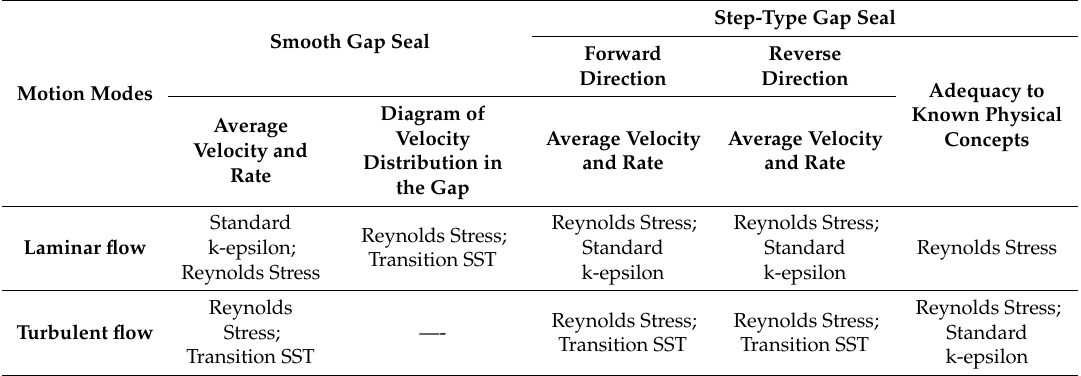
Table 9. The results of the analysis on using various flow models for calculating gap seals of piston hybrid power